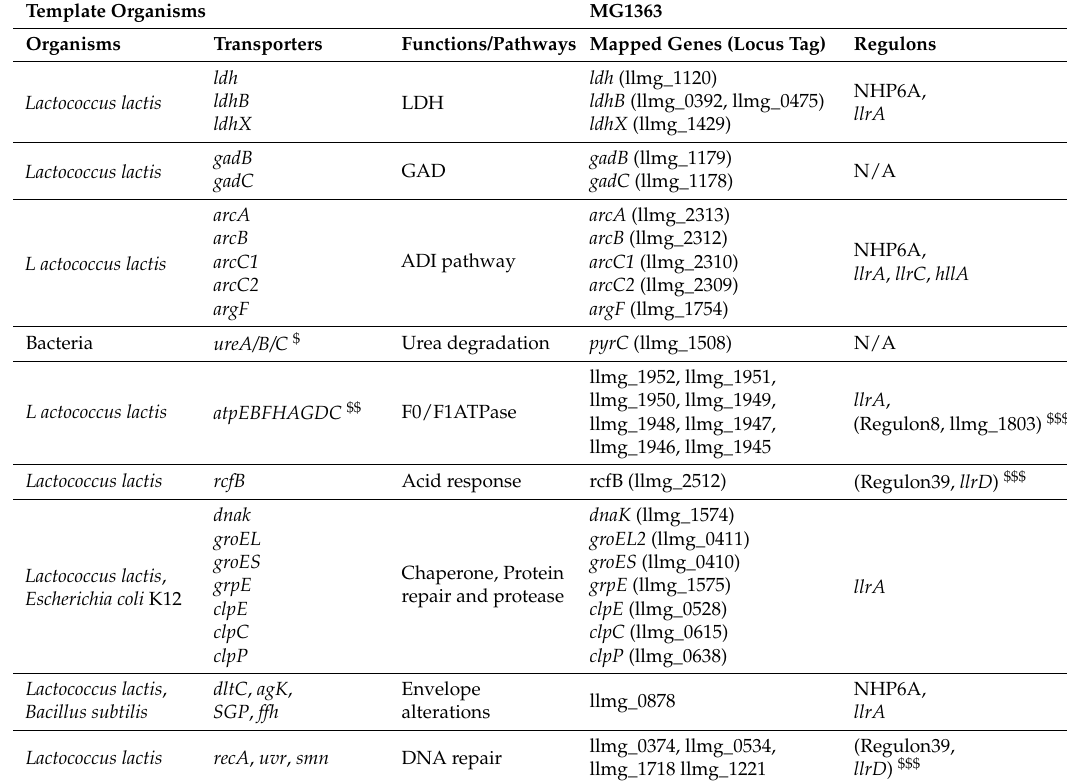
Known ASR-related gene mapping from literature in response to pH